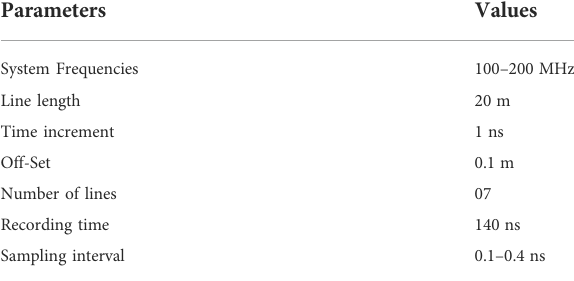
TABLE 1 GPR data acquisition parameters.